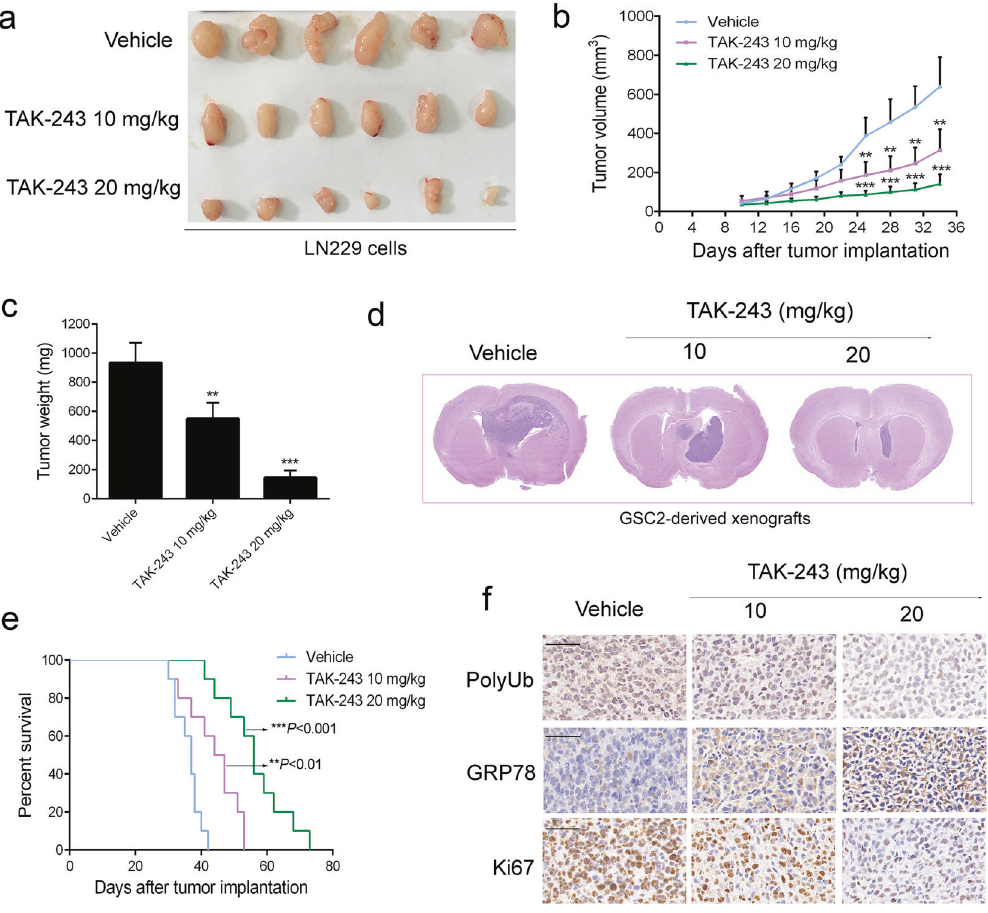
Fig. 7 TAK-243 suppresses tumor growth in vivo and increases the survival of animals bearing intracranial GSC2-derived tumors. a Representative tumors isolated from the control and TAK-243-treated groups of subcutaneous tumor model. b The mean tumor volumes were assessed at the indicated number of days after tumor implantation. c Tumors isolated from control and TAK-243-treated groups were weighted. The tumor weight was analyzed statistically. d Mice bearing GSC2-derived xenograft tumor were treated with TAK-243 (10 or 20 mg/ kg) or vehicle control by intraperitoneally injection twice a week for 4 weeks. Representative images of H&E staining of whole-brain sections from the control group and TAK-243 treatment group. e Kaplan − Meier survival curves of mice implanted with GSC2 cells ( n = 10). The survival time of tumor-bearing mice was counted. f Representative IHC staining images of polyubiquitin (polyUb), GRP78, and Ki67 expression in GSC2-derived xenograft tumor of control and TAK-243 treatment groups, scale bar: 50 μ m. All the data are expressed as means ± SD. ** P < 0.01, *** P <